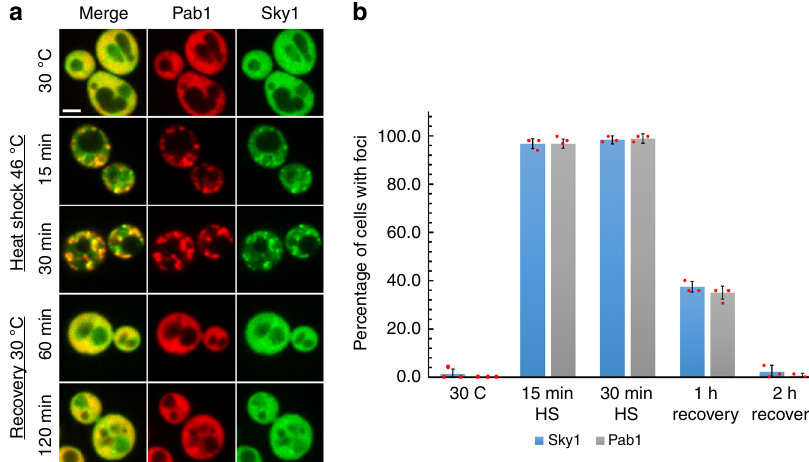
Fig. 1 Sky1 is a stress granule protein. a Sky1 colocalizes with Pab1 foci during heat stress. Yeast expressing Sky1-GFP and Pab1-mCherry from the corresponding endogenous loci were grown at 30 °C to mid-log, subjected to heat shock at 46 °C, and allowed to recover at 30 °C. Cells were visualized by fl uorescence microscopy during heat shock and recovery. Scale bar, 2 μ m. b Quanti fi cation of the percentage of cells with Pab1 (gray bar) or Sky1 (blue bar) foci. Data represent means± SD of n = 3 independent replicates. Source data are provided as a Source Data fi